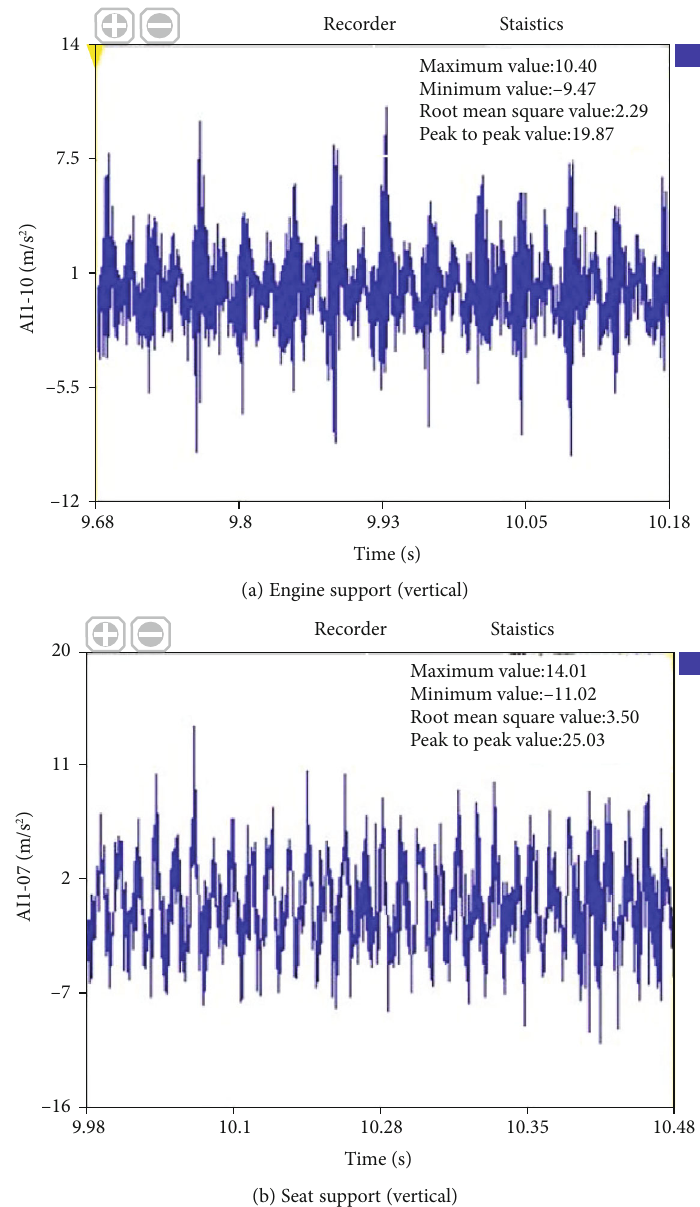
Figure 5: Time-domain curve of each measuring point when the engine is working (small Table 4: Vibration frequency and amplitude of each measuring point under engine idling conditions (small accelerator). Measuring point Peak serial number